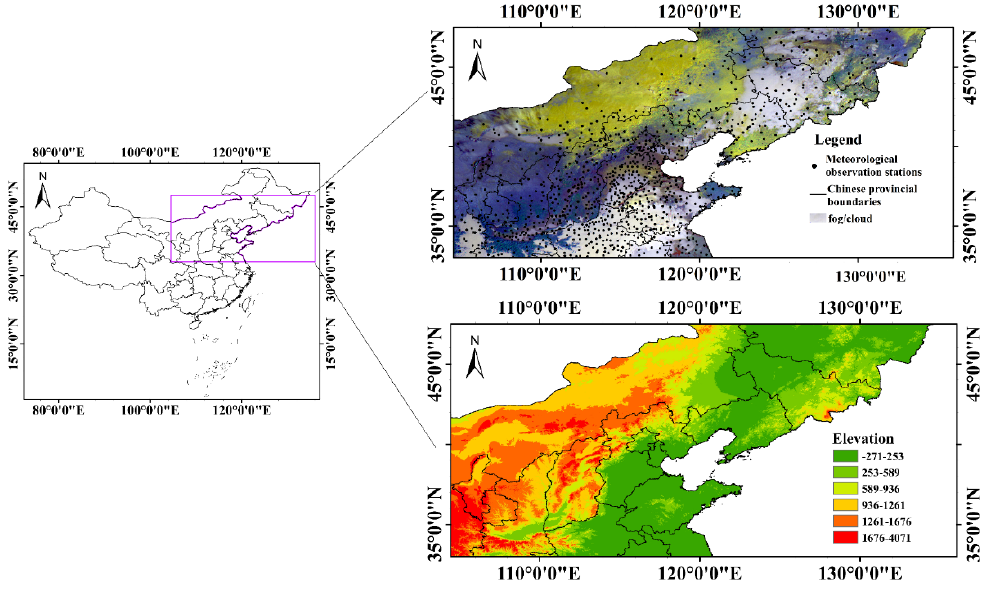
Figure 1. The study area.